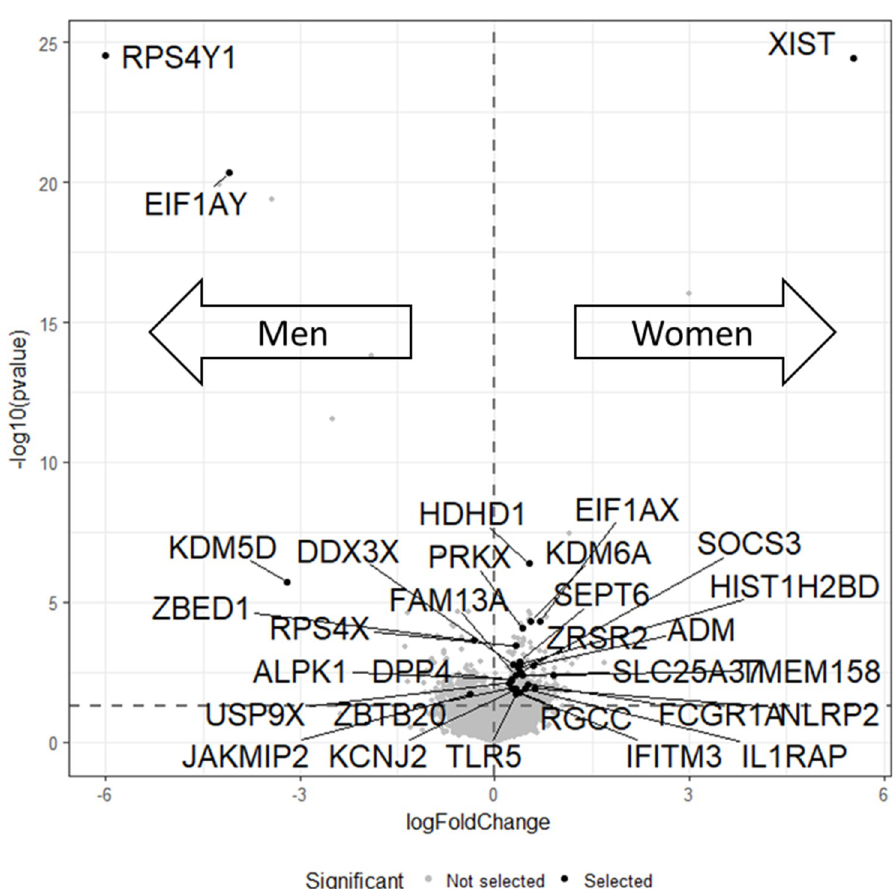
Fig 2. Sex differences in gene expression in three microarray experiments. Volcano plot with fold changes over p- values. Data of three independent microarray experiments were screened for sex differences. Means were computed for fold changes and p-values. Fold changes are displayed on a logarithmic scale and p-values on a scale of the negative decadic logarithms. Points right of the vertical dashed line correspond to higher expression in women and vice versa. The horizontal dashed line indicates the significance level 0.05 with points above this line representing an average p- value < 0.05. Genes, which were significantly and consistently differentially expressed in all three experiments are represented as black dots with names. They were selected for GO Category analysis and literature